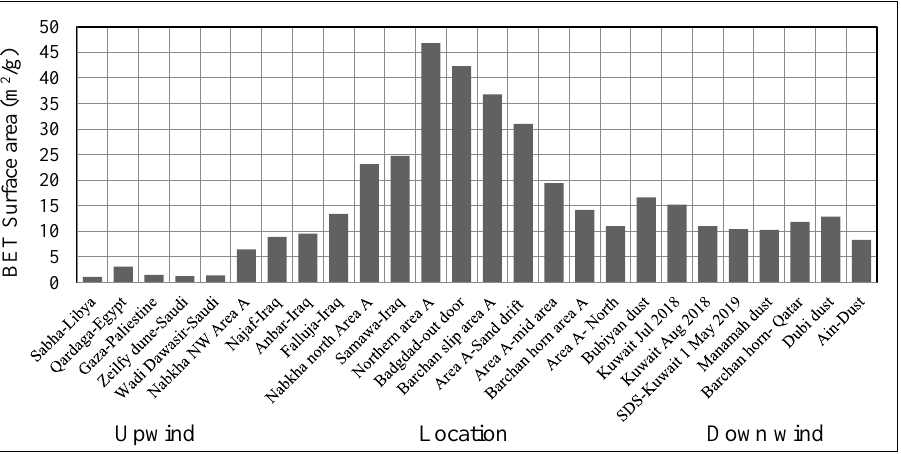
Figure 19. The dust BET surface area in the hotspot (A) compared to up- and downwind collected dust samples.